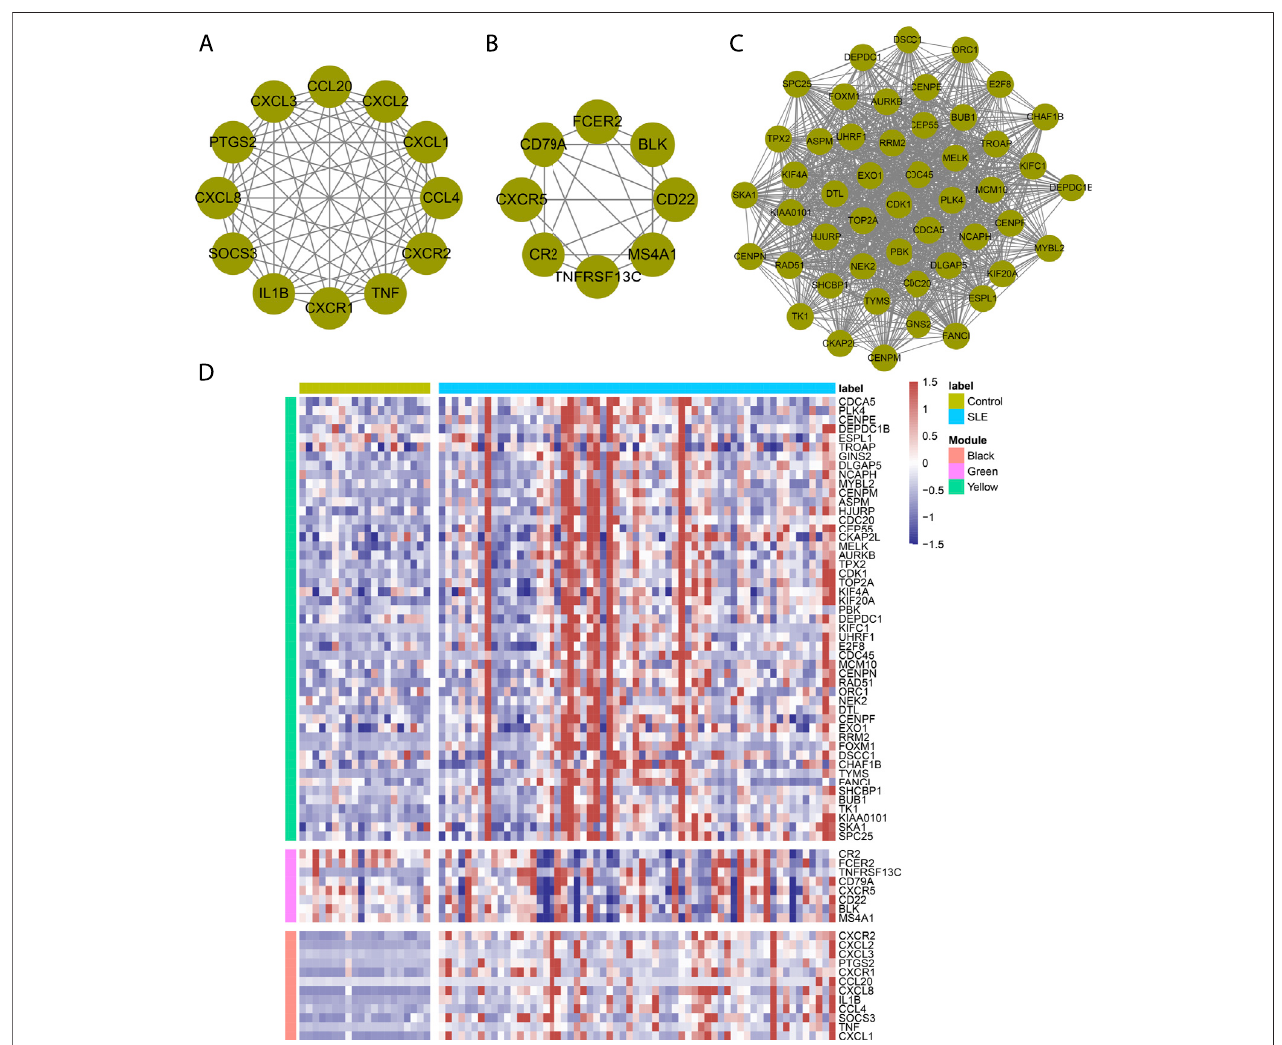
FIGURE 3 | Determination of immune cell-relevant hub genes. (A – C) Hub gene clusters in the (A) black, (B) green, and (C) yellow modules through MCODE approach. (D) Heatmap depicts the expression of hub genes in SLE and normal PBMCs in the GSE50772 dataset.